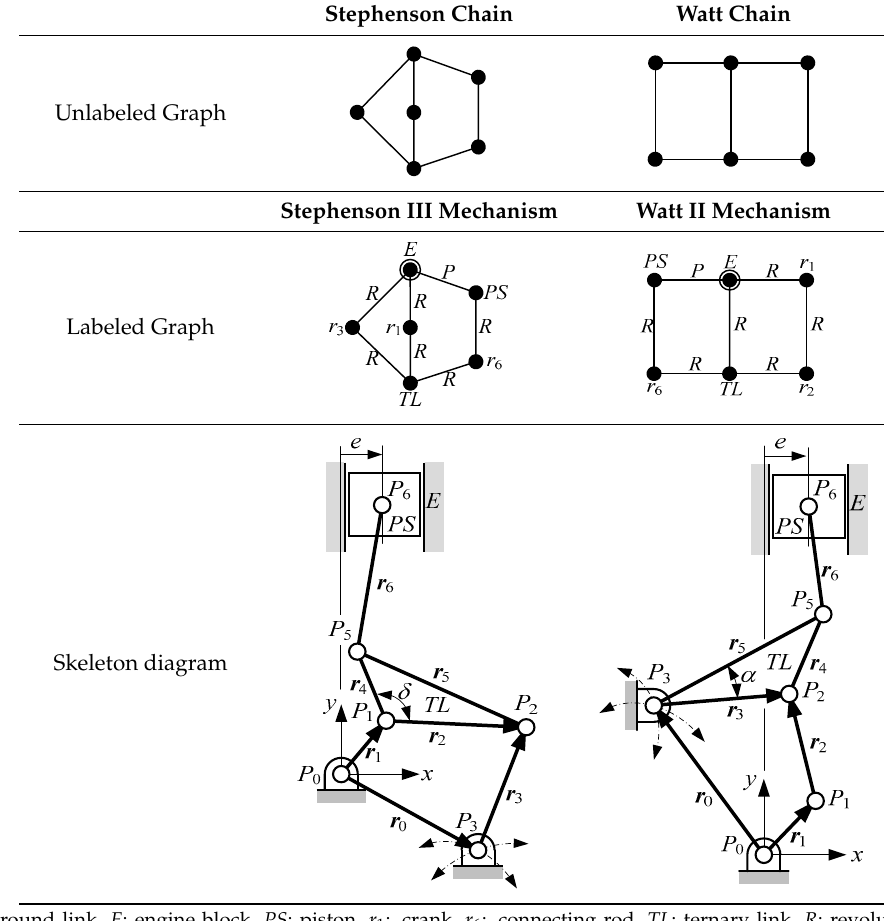
Table 1. Candidate variable compression ratio (VCR) engine mechanisms.